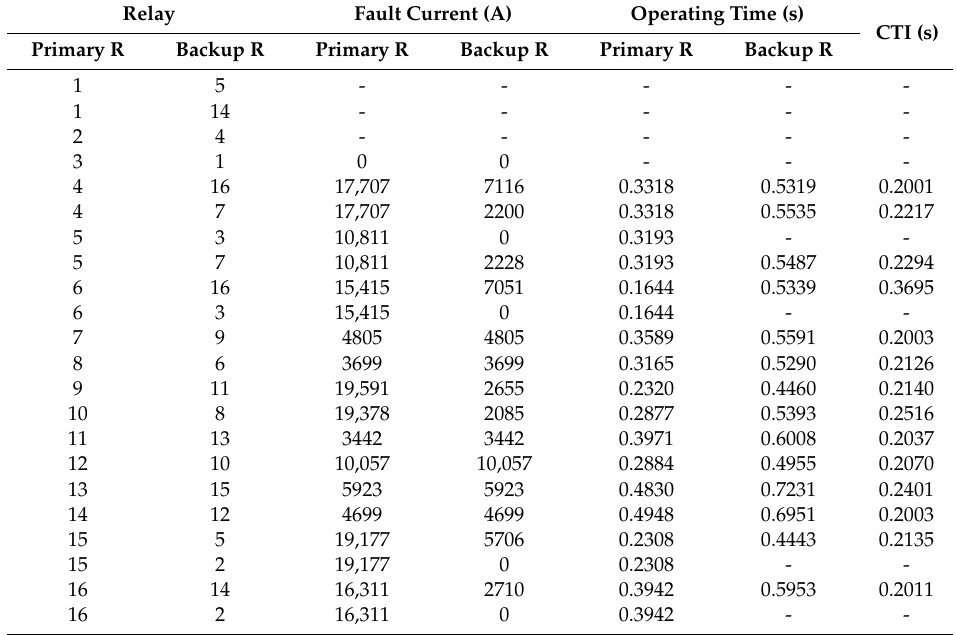
Table 16. Relay operating time and coordination time interval (CTI) of obtained settings for topology